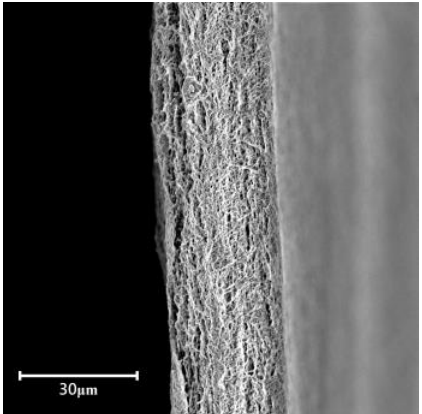
Figure 3. Cross-section of pure ePTFE membrane.